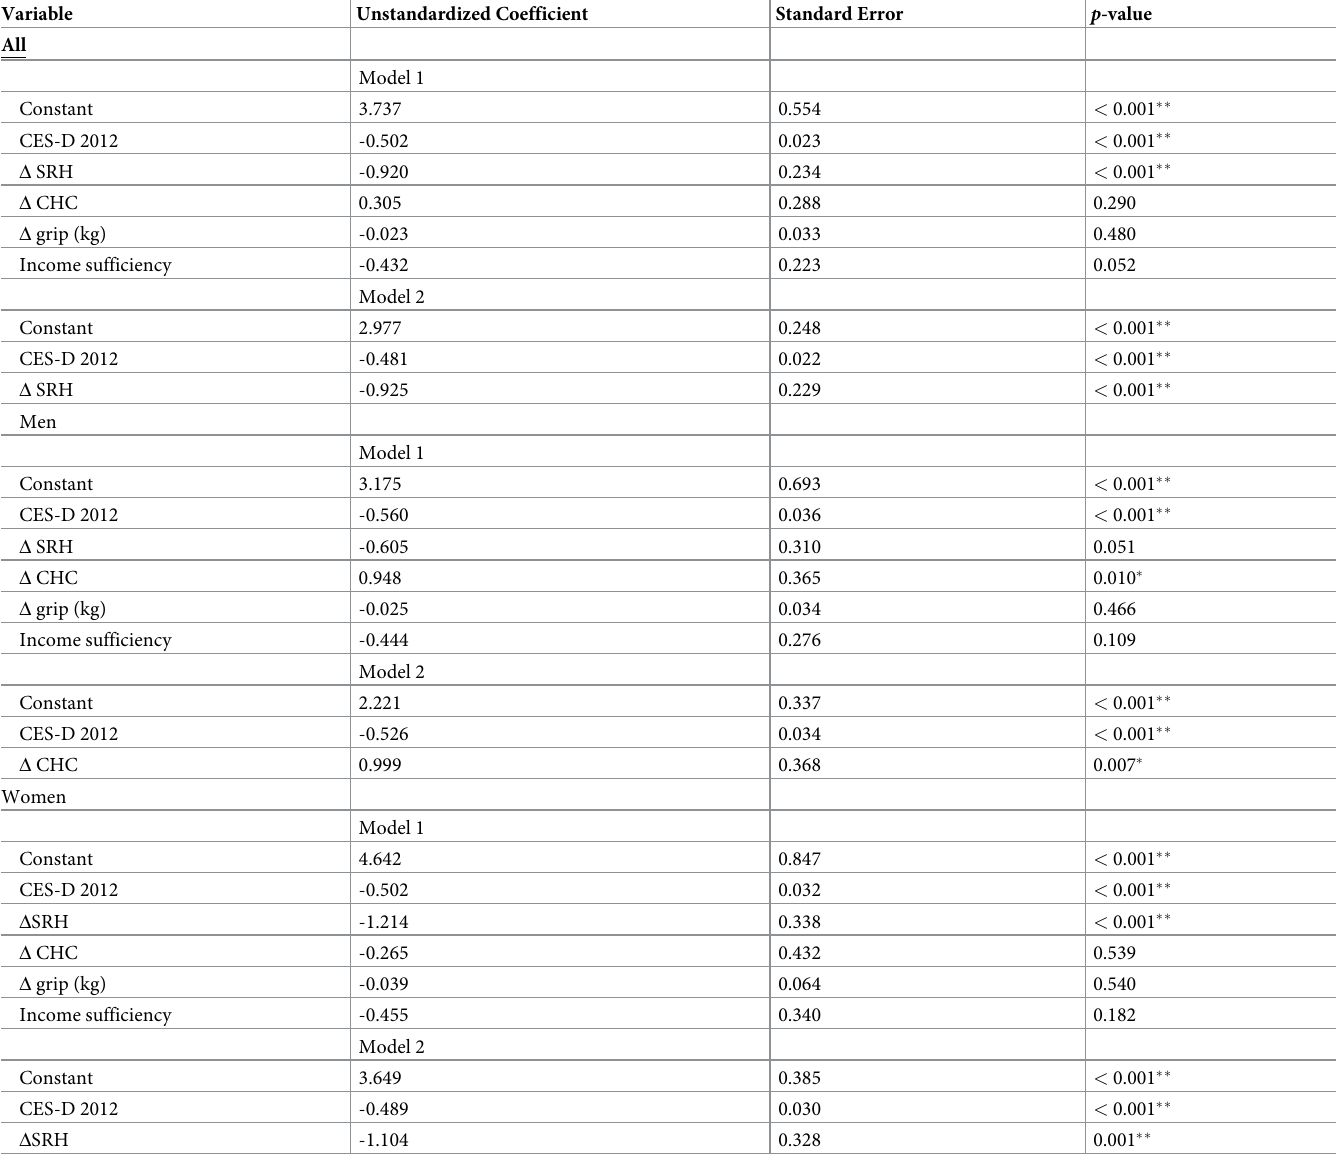
Table 4. Multiple Linear Regression–Predicting Δ Depression from 2012 to